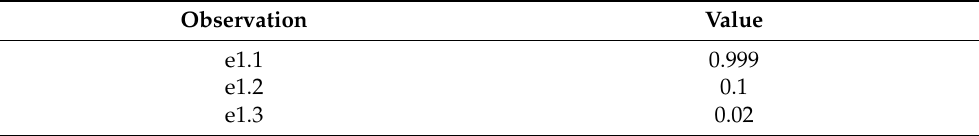
Table 1. Assignment of particular values for observing h1 (prepared by the authors).